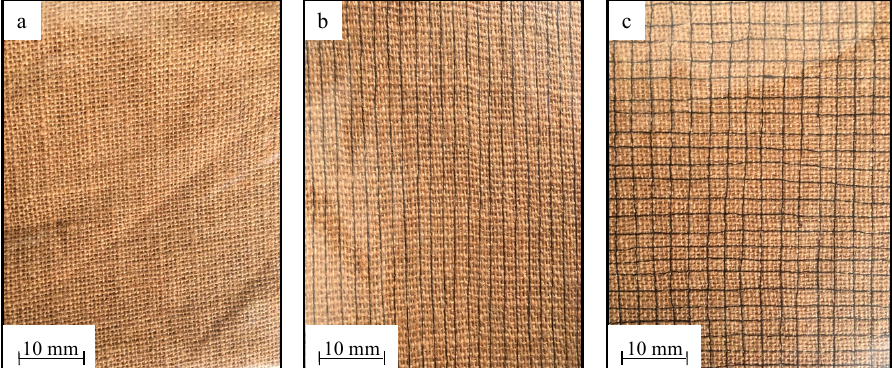
Figure 2. Unstitched and silk-fiber-stitched woven kenaf: ( a ) UNSTITCHED; ( b ) WKS/X; ( c ) WKS/XY.